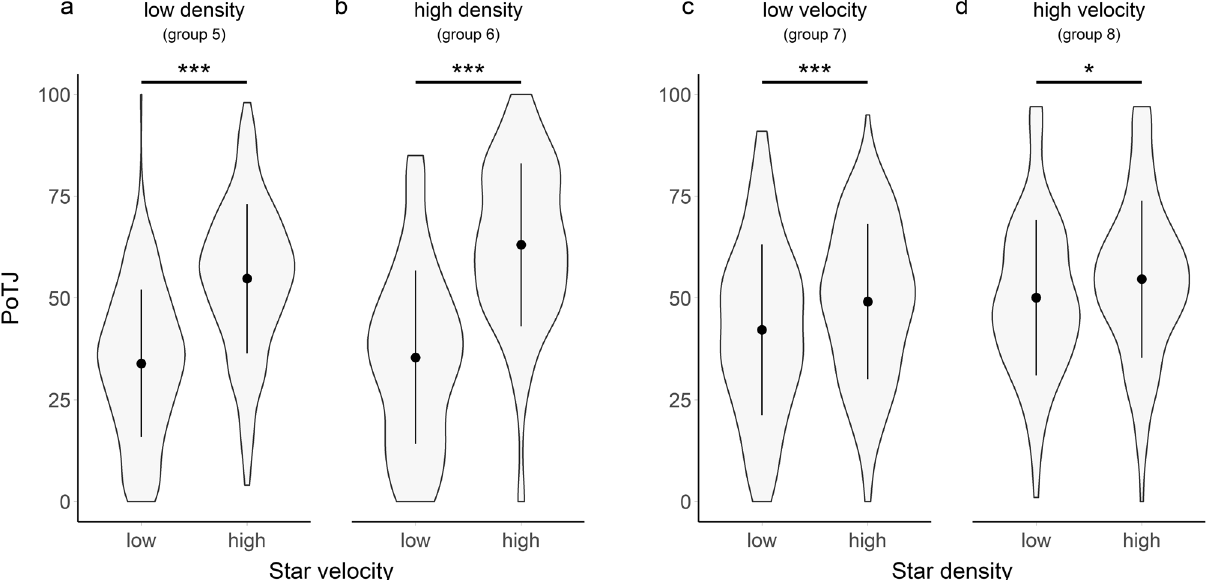
Figure 5. Violin plots of PoTJs (data from groups 5–8). In the groups 5 & 6 ( a , b ), the velocity of stars was manipulated (within subject manipulation), while density was kept at a constant level (Group 5: low; Group 6: high). In the groups 7 & 8 ( c , d ) the density of stars was manipulated (within subject manipulation), while speed was kept at a constant level (Group 7: low; Group 8: high). Central dots indicate the means over all subjects, central vertical lines indicate the sd. Asterisks indicate significant pairwise Tukey post-hoc test (* < 0.05; ** < 0.01, *** < 0.001; n.s.: not significant), corrected for multiple